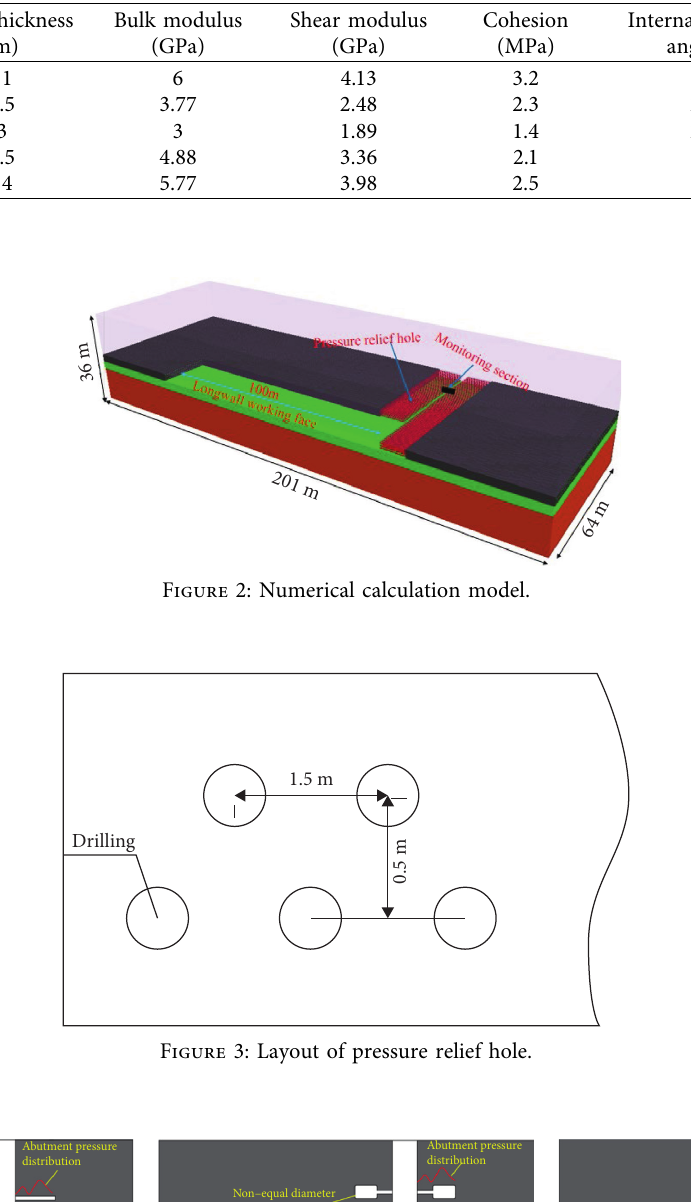
Table 1: Rock mechanical properties of each rock stratum.